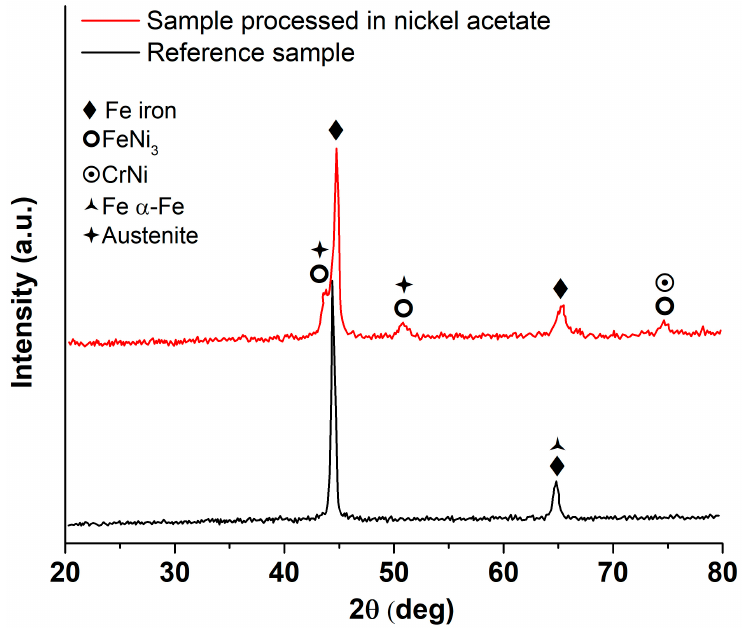
Figure 5. XRD pattern, black line reference sample (without processing) and red line sample processed in nickel acetate.